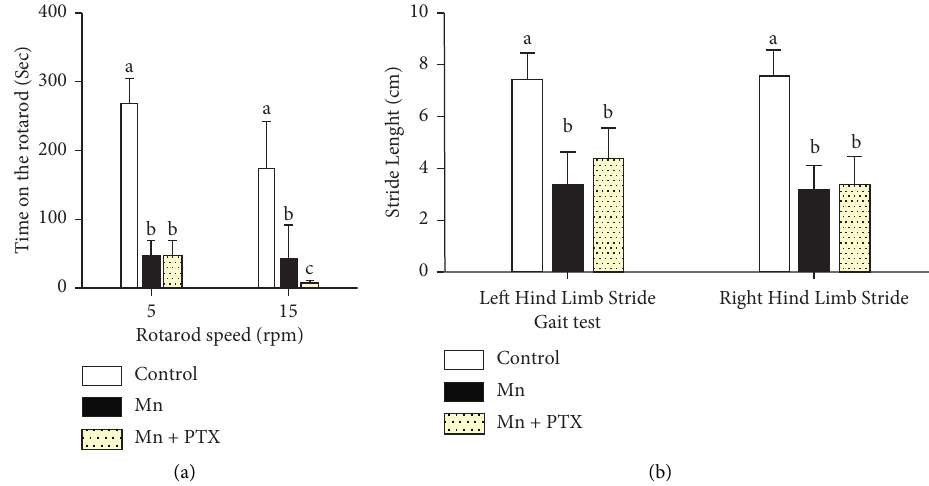
Figure 1: Effect of pentoxifylline supplementation on the animals’ locomotor activity in the rat model of manganism. (a) Rotarod test; (b) gait test. Data are represented as mean ± SD. According to the post hoc Tukey test which was used for intergroup comparisons, groups with the same superscripted letters were not significantly different at α � 0.05 ( P ≥ 0 . 05 ) . However, dissimilar letters indicate a significant difference ( P < 0 . 05 ) .